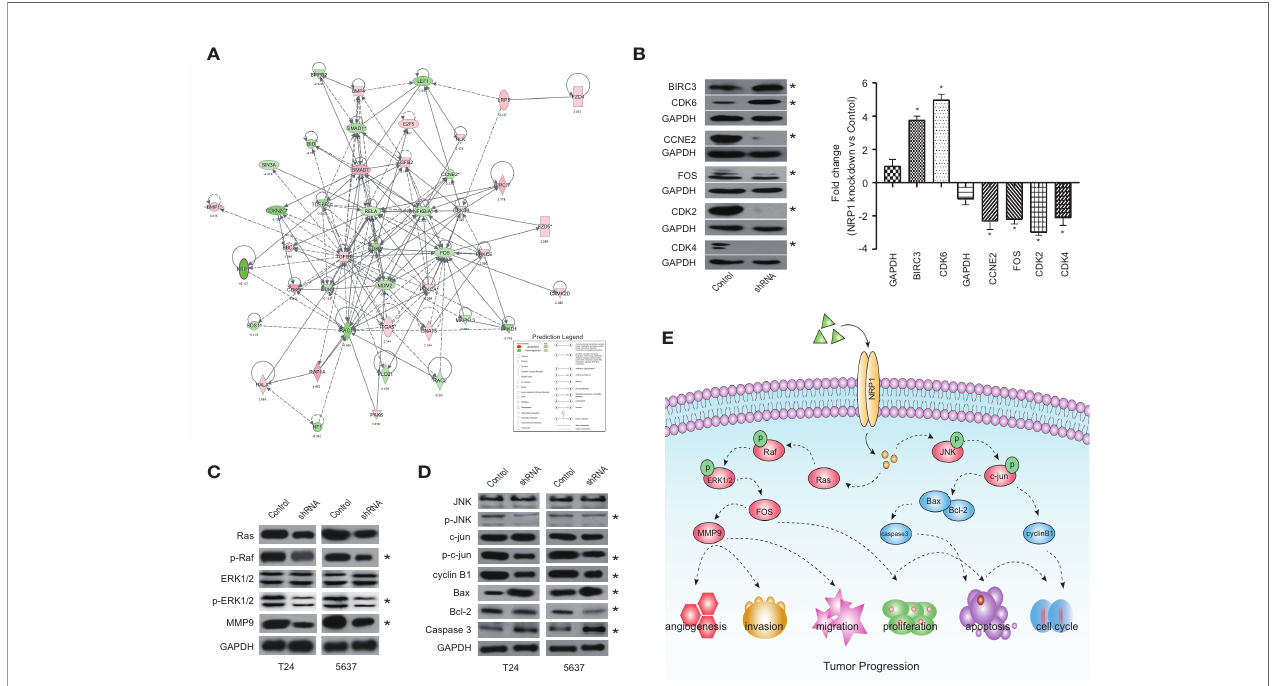
FIGURE 6 | Validation of pathways associated with NRP1 silencing. (A) The gene network map of molecular mechanisms of cancer pathway including the potential NRP1-regulated genes. (B) The protein expression of some known tumor-associated genes in molecular mechanisms of cancer pathway were con fi rmed using western blot in T24 cells with NRP1 knockdown. Western blot was performed in three independent experiments and independently represent each internal control (GAPDH). (C) Western blot of ERK/MAPK related protein expression in T24 and 5637 BC cells after NRP1 knockdown. (D) Western blot of JNK/MAPK related protein expression in T24 and 5637 BC cells after NRP1 knockdown. (E) Proposed model for the molecular mechanisms underlying the action of NRP1 in BC progression. * p < 0.05 vs. the control